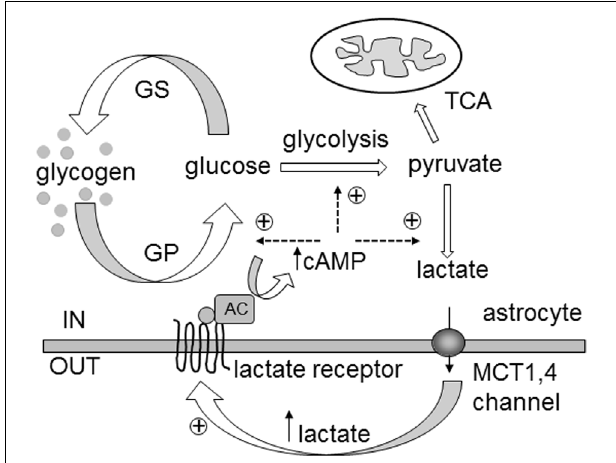
FIGURE 7 | Extracellular L -lactate controls cytosolic lactate synthesis via yet unidentified receptors coupled to adenylate cyclase activity and cytosolic cAMP increase in astrocytes. In the brain, L -lactate is formed in the cytoplasm of astrocytes (IN) and is released through monocarboxylate transporters (MCTs) 1,4 and/or lactate-permeable channels. Extracellularly (OUT), L -lactate can be transported to neighboring cells as a fuel. However, it can also act as a signaling molecule by binding to the L -lactate receptors of neighboring cells, stimulating adenylate cyclase activity (AC) and an increase in cAMP synthesis. Elevated cytosolic cAMP levels facilitate glycogen degradation by activating glycogen phosphorylase (GP) and glycolysis with L -lactate as the end product. In the absence of the L -lactate positive feedback mechanism (“metabolic excitability”), the L -lactate tissue concentration gradient could be dissipated, reducing the availability of L -lactate as a metabolic fuel, when local energy demands, especially in the brain, are high. This model shares similarities with the ‘autocrine lactate loop’ acting (oppositely) on [cAMP] i through GPR81 receptor in adipocytes (Ahmed et al., 2010). GS, glycogen synthase; TCA, tricarboxylic acid cycle. Glucose denotes phosphorylated and free